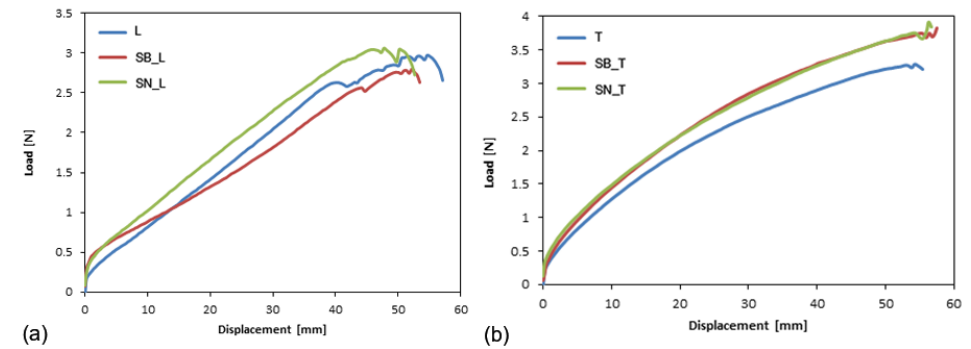
Figure 5. Typical load-displacement curves for longitudinal ( a ) and transverse ( b ) ETFE specimens, before and after aging.